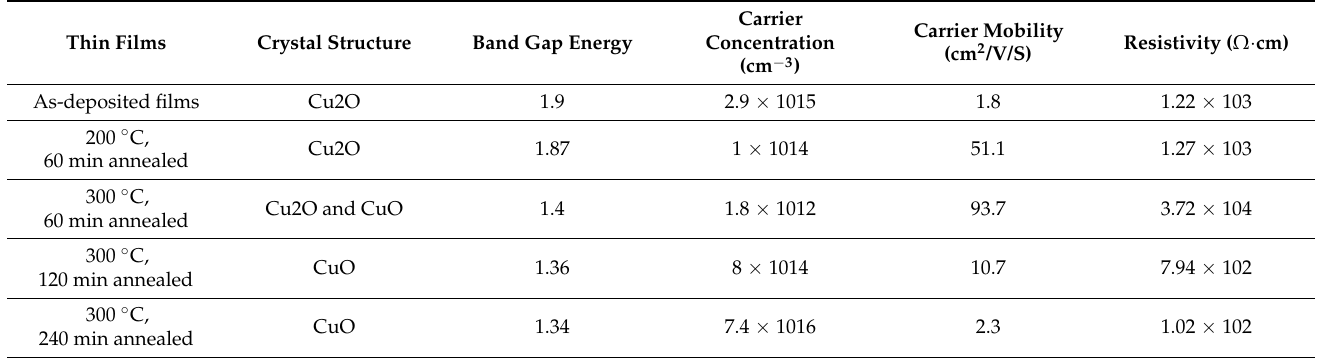
Table 3. Summary of crystallinity and electricity parameters in the obtained films